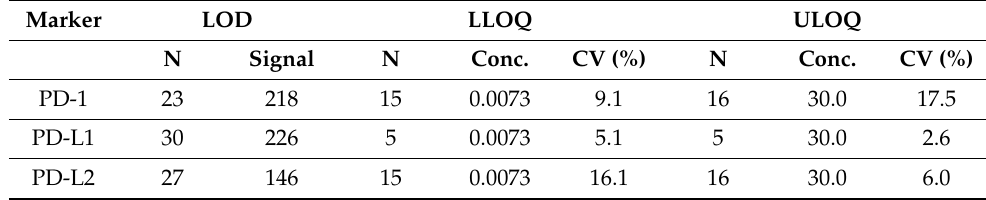
Table 3. Assay specifications including LOD, LLOQ and